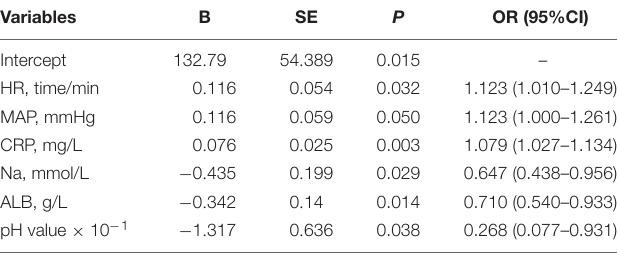
TABLE 2 | Multivariate logistic regression model of intestinal necrosis.